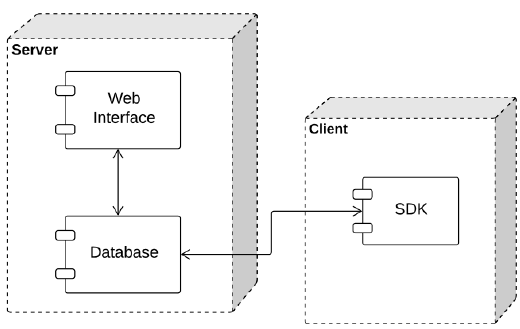
Figure 6. Subscription solution components diagram.